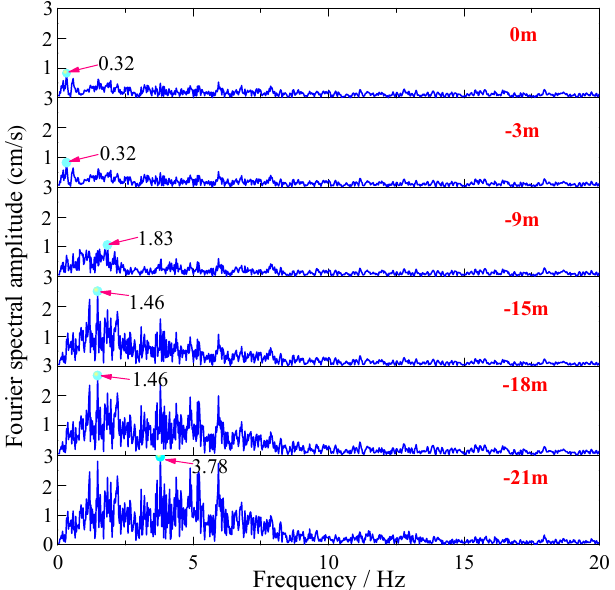
Figure 11. Acceleration Fourier spectra at different depths under the El-Centro motion.